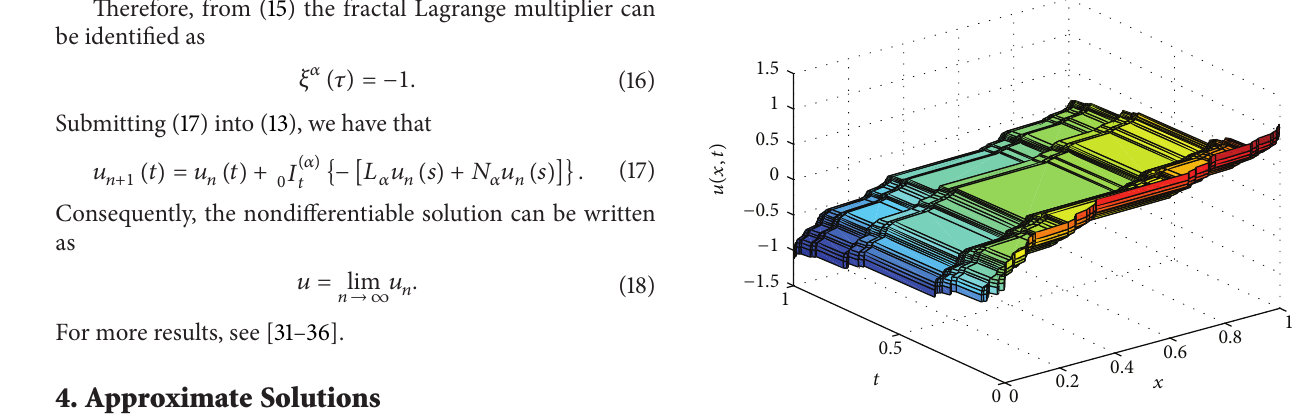
Figure 1: The plot of solution of (19) when 𝛼 = ln 2/ ln 3